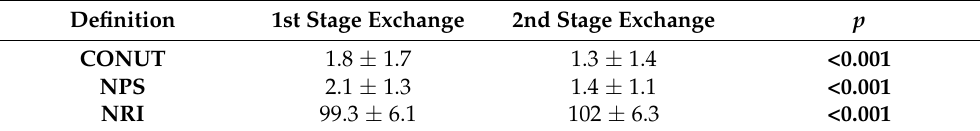
Table A1. Evolution of patient nutritional status in the two-stage exchange.